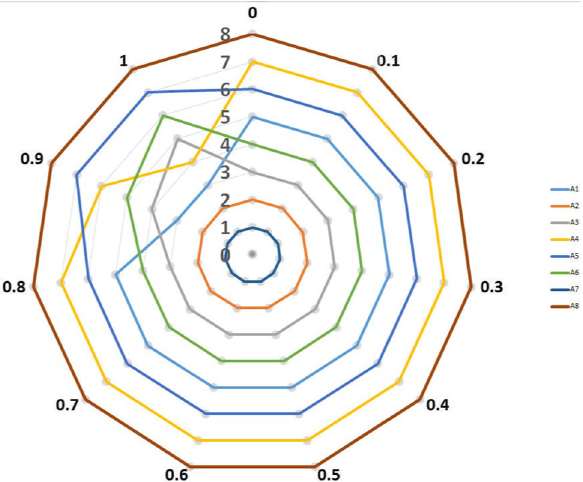
Fig. 6 Robust analysis results of hotel